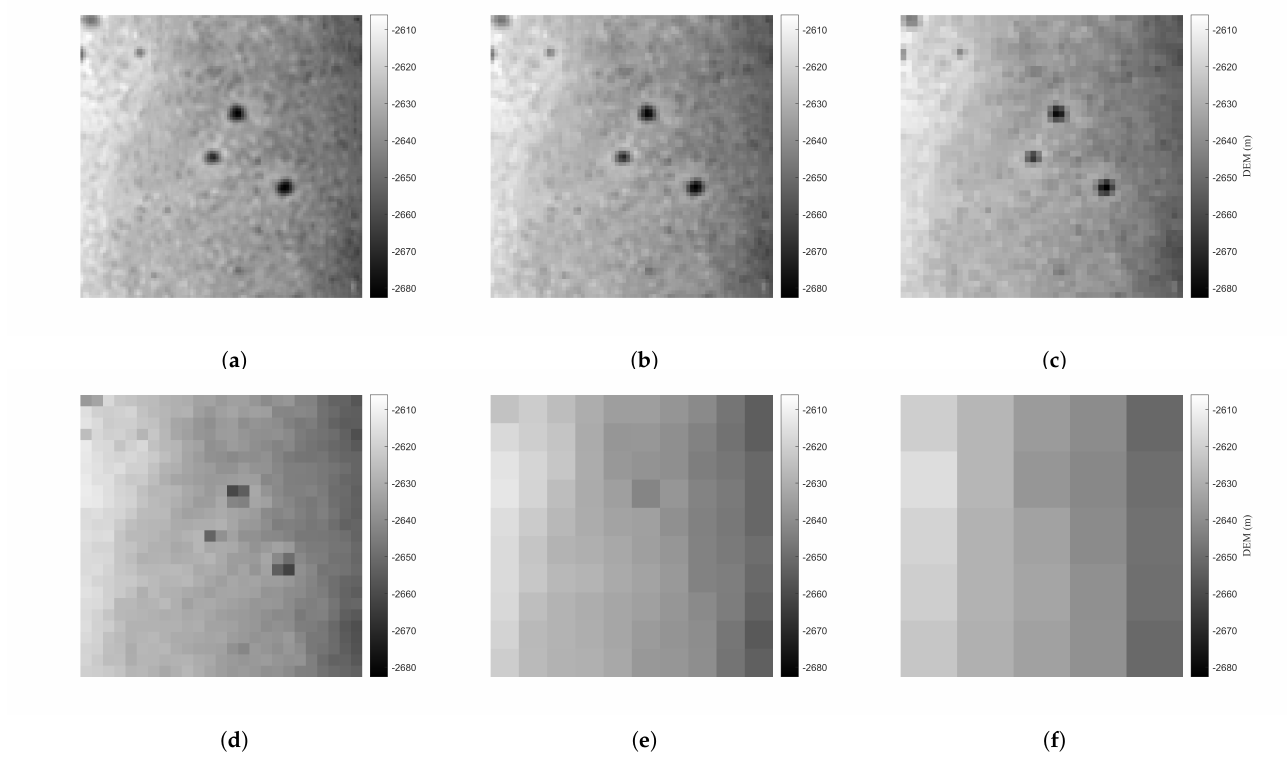
Figure 1. Chang’e-3 landing region. The data from the lunar orbital laser altimeter (LOLA) used to create the multiscale digital elevation models (DEMs): ( a ) 60 m per pixel, ( b ) 80 m per pixel, ( c ) 120 m per pixel, ( d ) 240 m per pixel, ( e ) 600 m per pixel, ( f ) 1200 m per